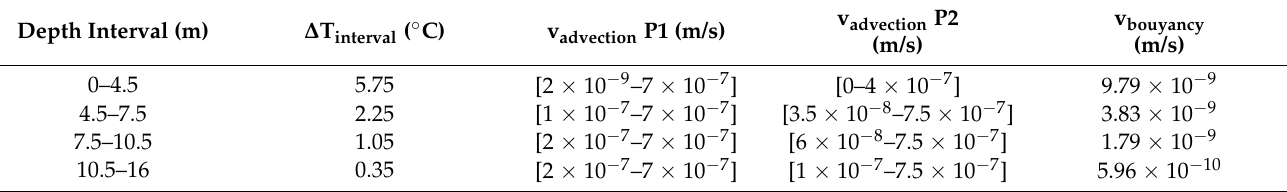
Table 6. Comparison between advection and convection velocities for each depth